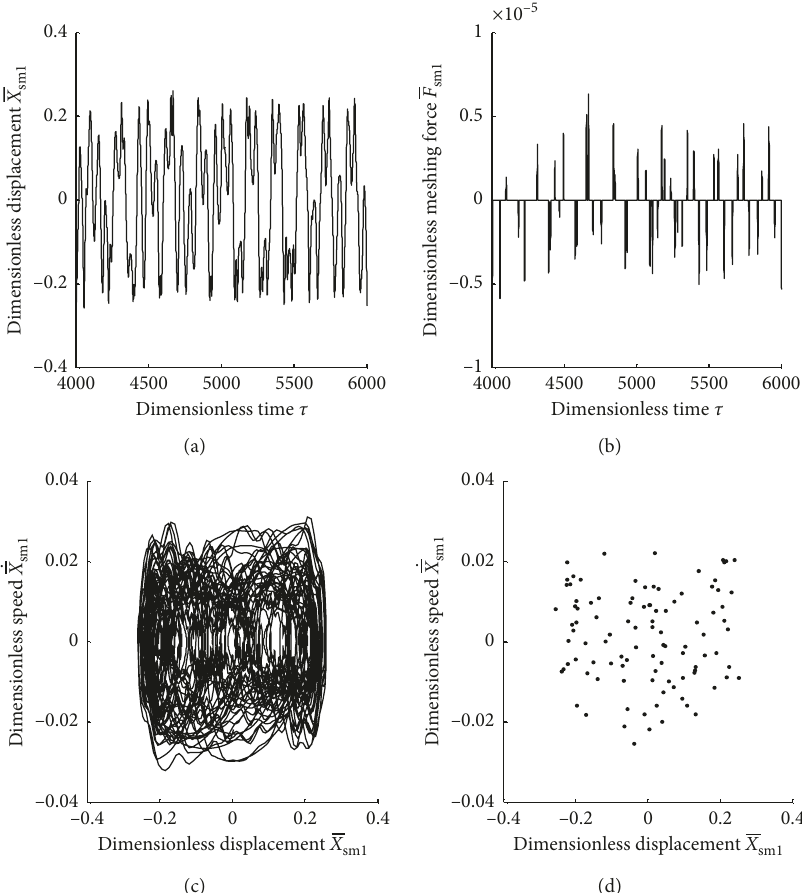
Figure 6: Process diagrams of response, phase diagram, and Poincar´e section under b � 20 μ m for encased stage. (a) Time process diagram of displacement response. (b) Time process diagram of meshing force response. (c) Phase diagram. (d) Poincar´e